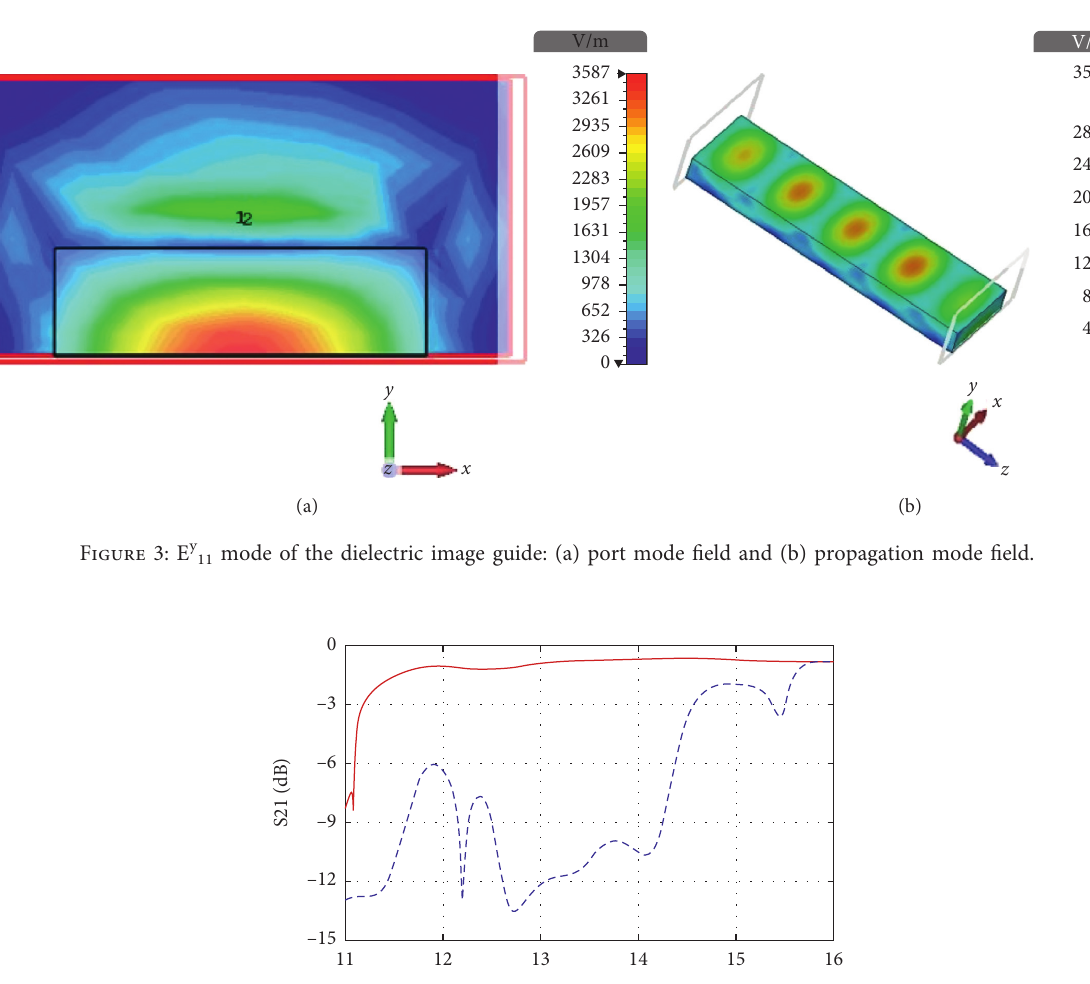
and E y , respectively) of the grounded 11 21